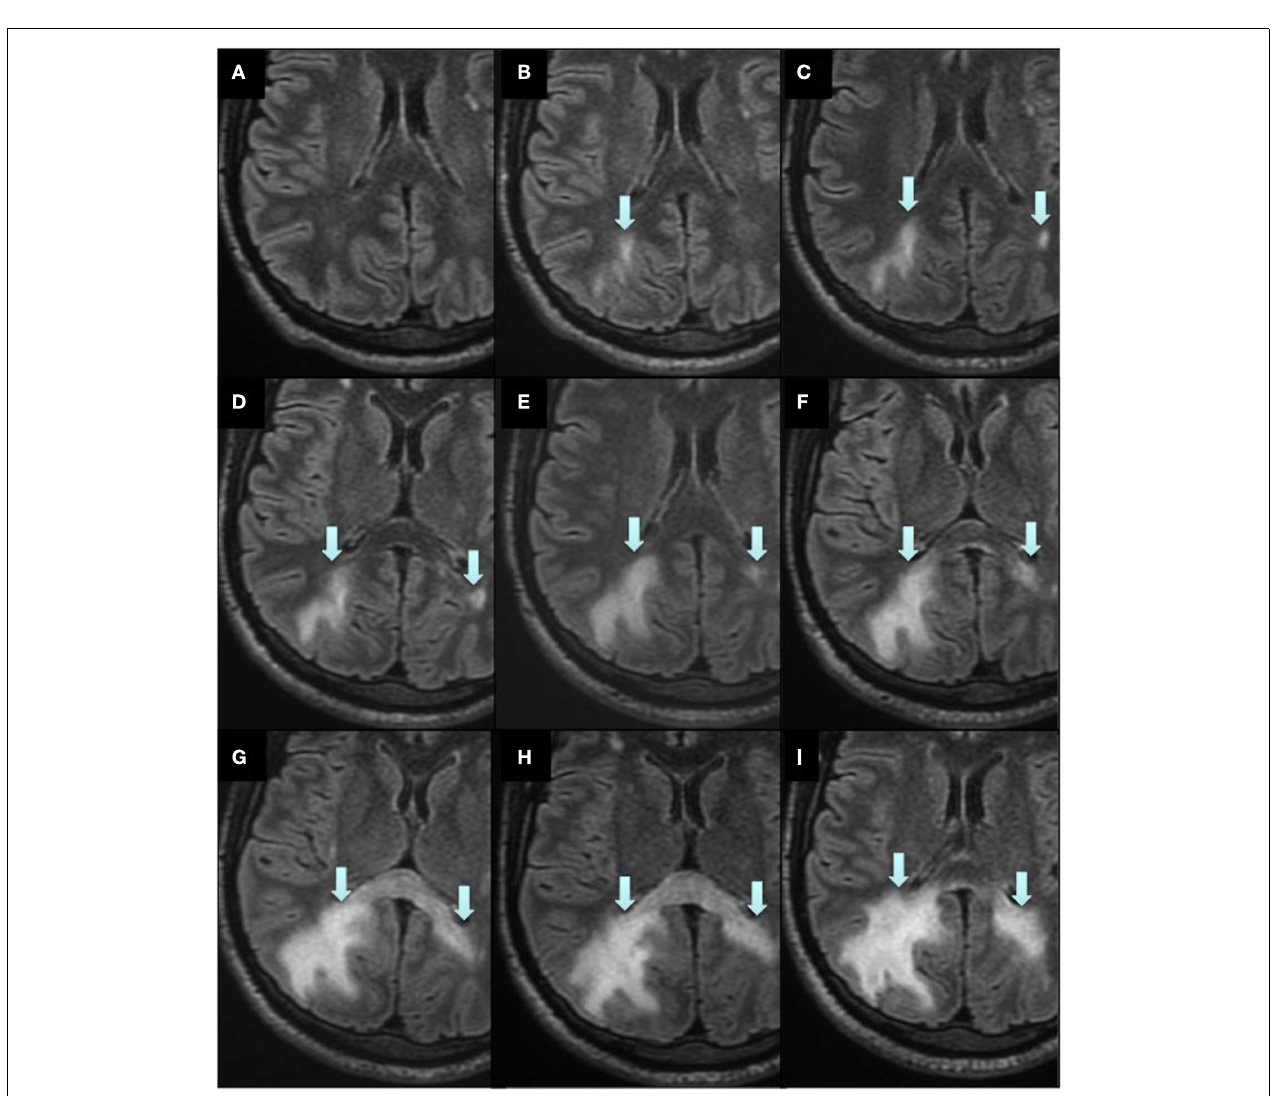
scans directly after plasma exchange (C) , 1week (D) , 2weeks (E) , 4weeks (F) , 5weeks (G) , 1.5months (H) , and 2.5months (I) after plasma exchange. Arrows indicate the PML